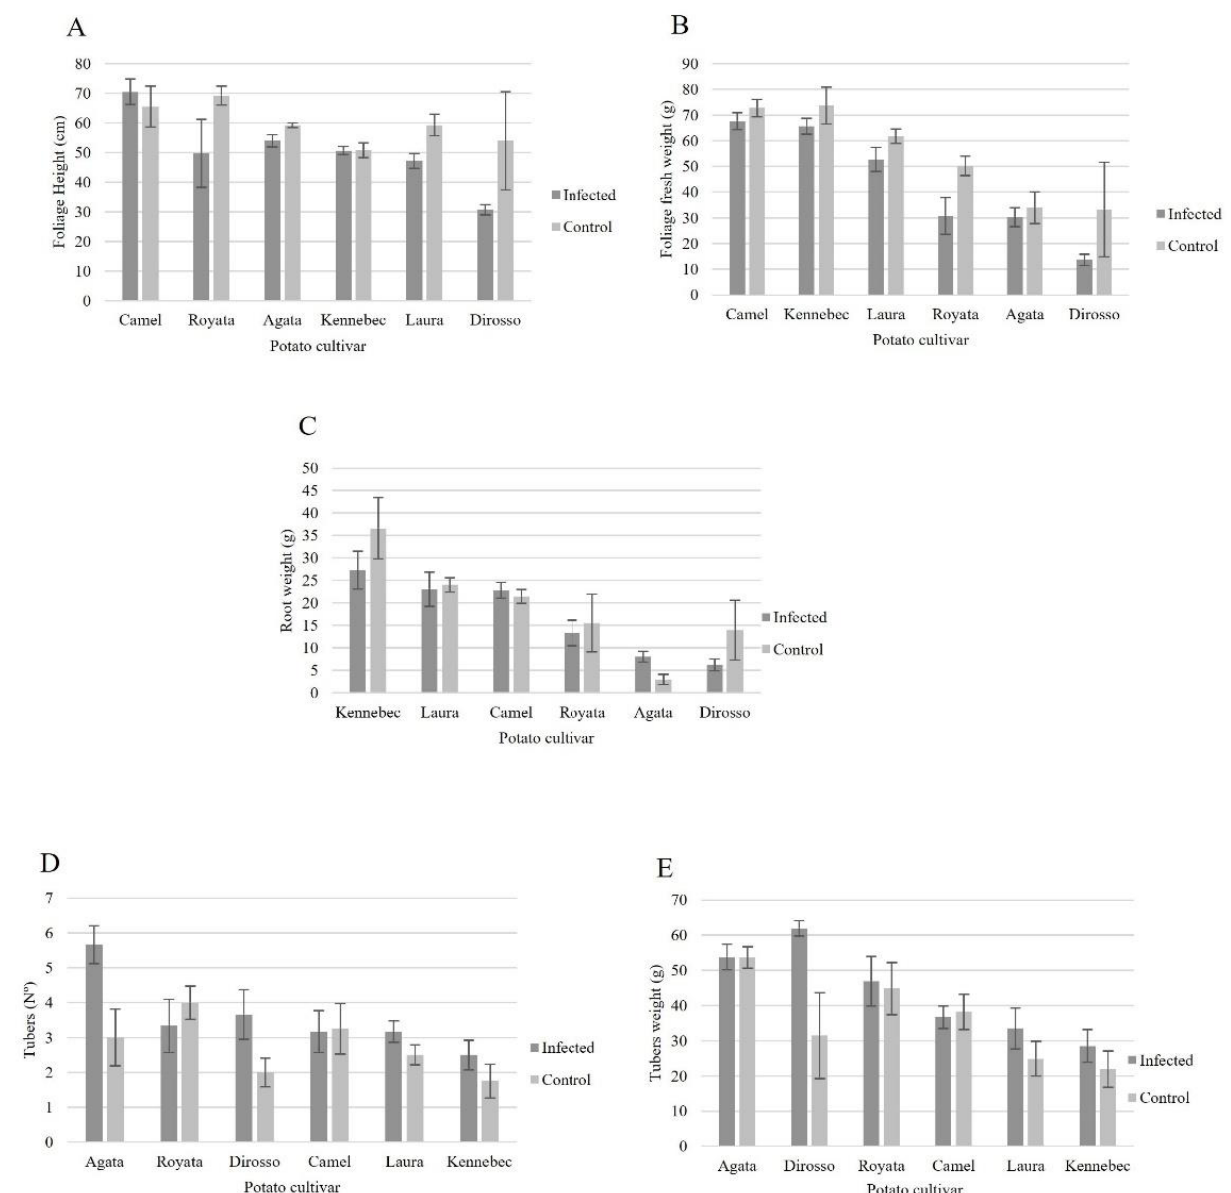
Figure 6. Plant growth assessment in Assay 2: ( A ) foliage height; ( B ) foliage fresh weight; ( C ) root fresh weight; ( D ) number of tubers; ( E ) tuber weight. Data are the means of six replicates ± SE. No significant differences were found between foliage, root, and tuber parameters of inoculated versus non-inoculated plants according to the Fisher LSD test.